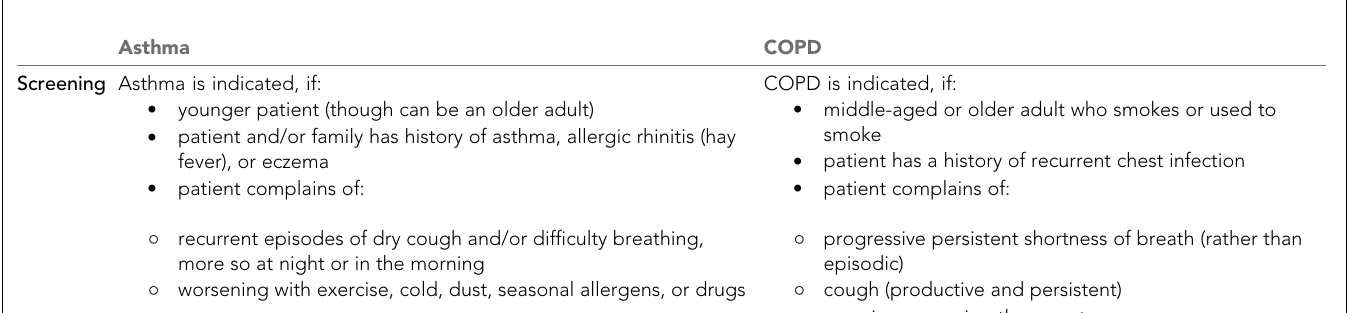
Assess for asthma or COPD diagnosis, if one or more of the above